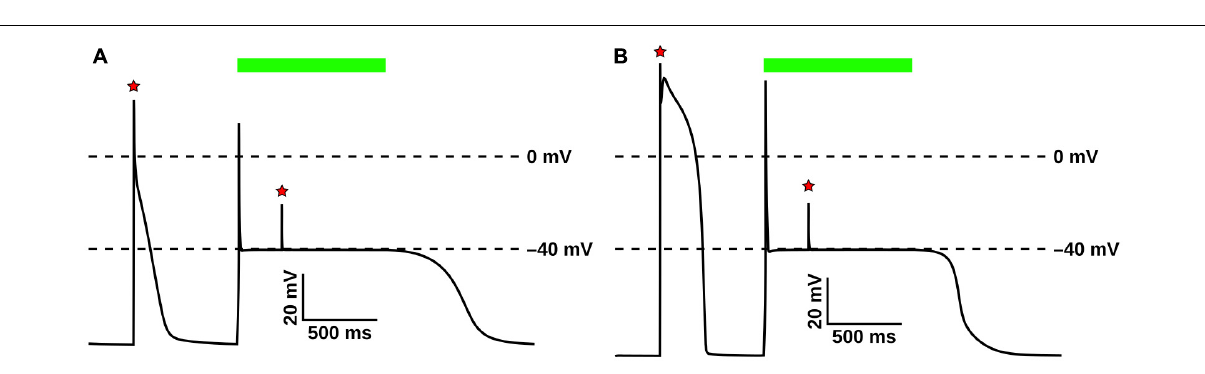
Figure 8 . In a representative GtACR1-expressing